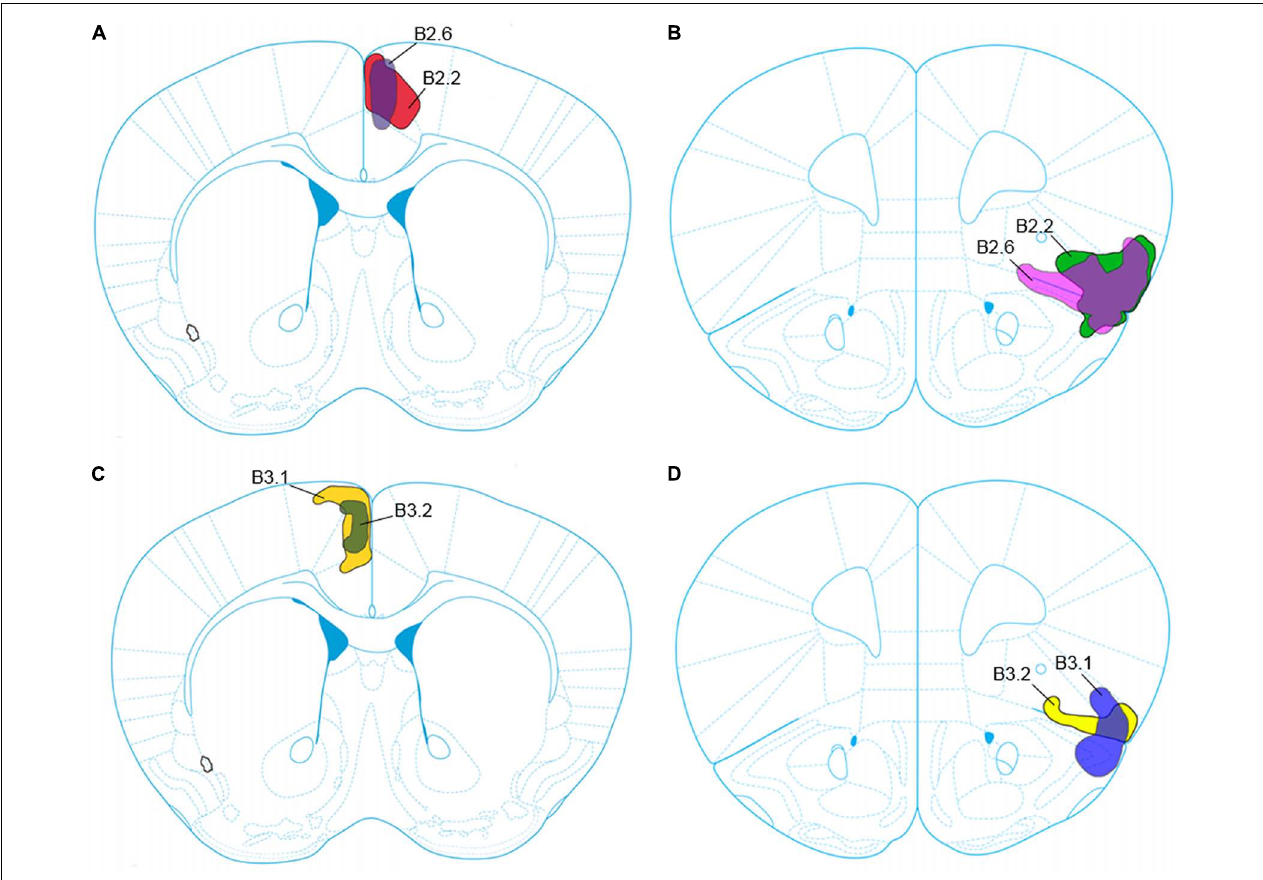
FIGURE 1 | Schematic representation of the core and penumbra of the viral tract tracer injection into the anterior cingulate cortex (ACC) for cases B2.2 and B2.6 (A) , and into the anterior insular cortex (aINS) for cases B2.2 and B2.6 (B) . Viral tract tracer injection core and penumbra for cases B3.1 and B3.2 into the ACC are depicted in (C) and into the aINS depicted in (D)